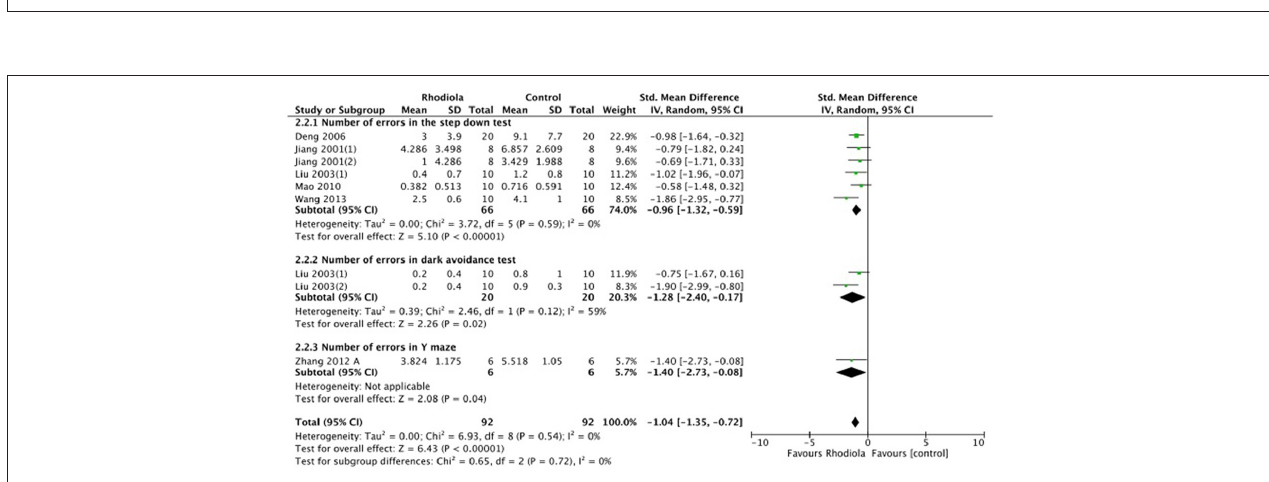
FIGURE 4 | The forest plot: effects of Rhodiola rosea L. For decreasing the number of errors compared with control group.